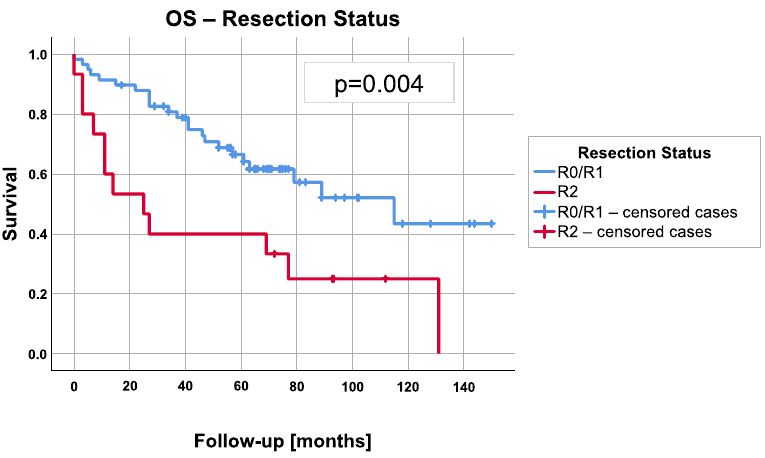
Figure 3. Overall survival (OS) depending on postoperative resection status.